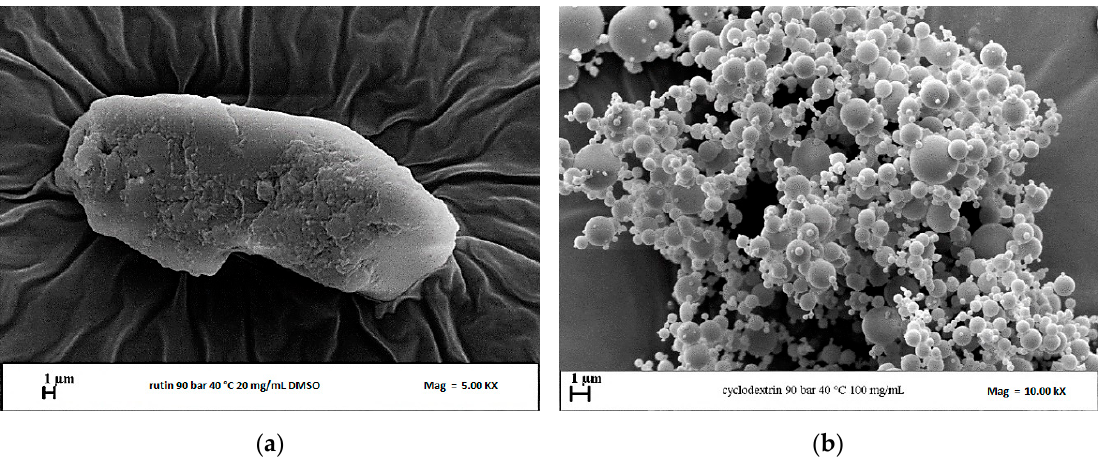
Figure 2. FESEM images of powders precipitated from DMSO at 9 MPa and 40 °C: ( a ) RUT (run #1); ( b ) β‐ CD (run #2).